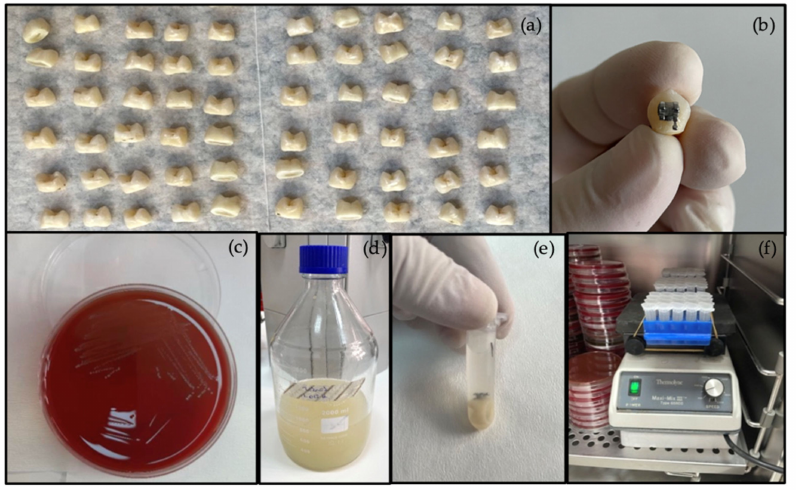
Figure 1. ( a ) Teeth whose roots were removed with a separator disc before bonding; ( b ) bonded tooth sample; ( c ) Streptococcus mutans medium; ( d ) artificial saliva solution; ( e ) specimen ready to be